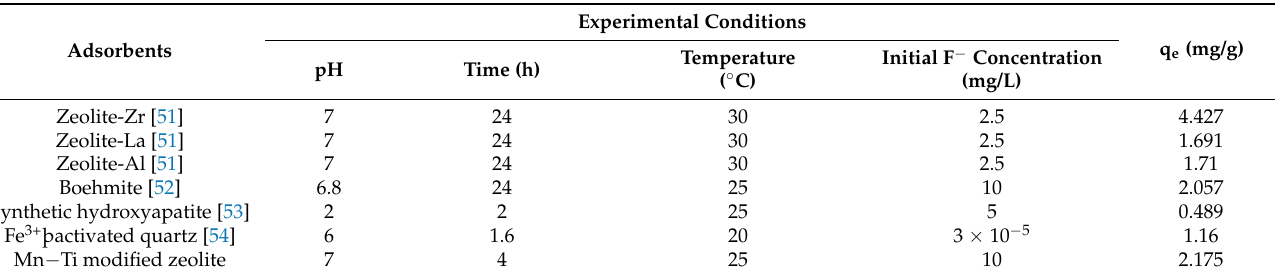
Table 4. A comparison of the adsorption capacity.